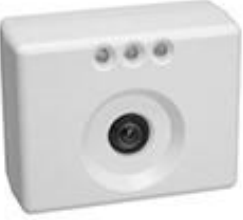
Figure 4. Pyro Thermal Sensor by FLIR.